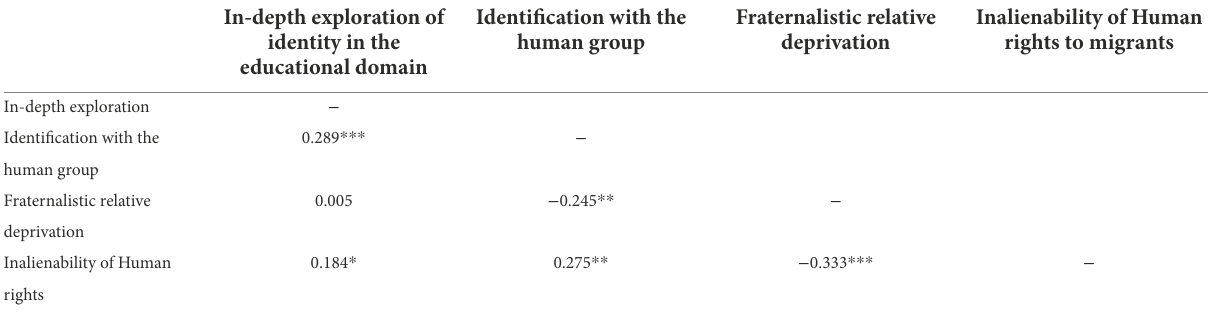
TABLE 3 Pearson’s correlations among study’s variables ( N =